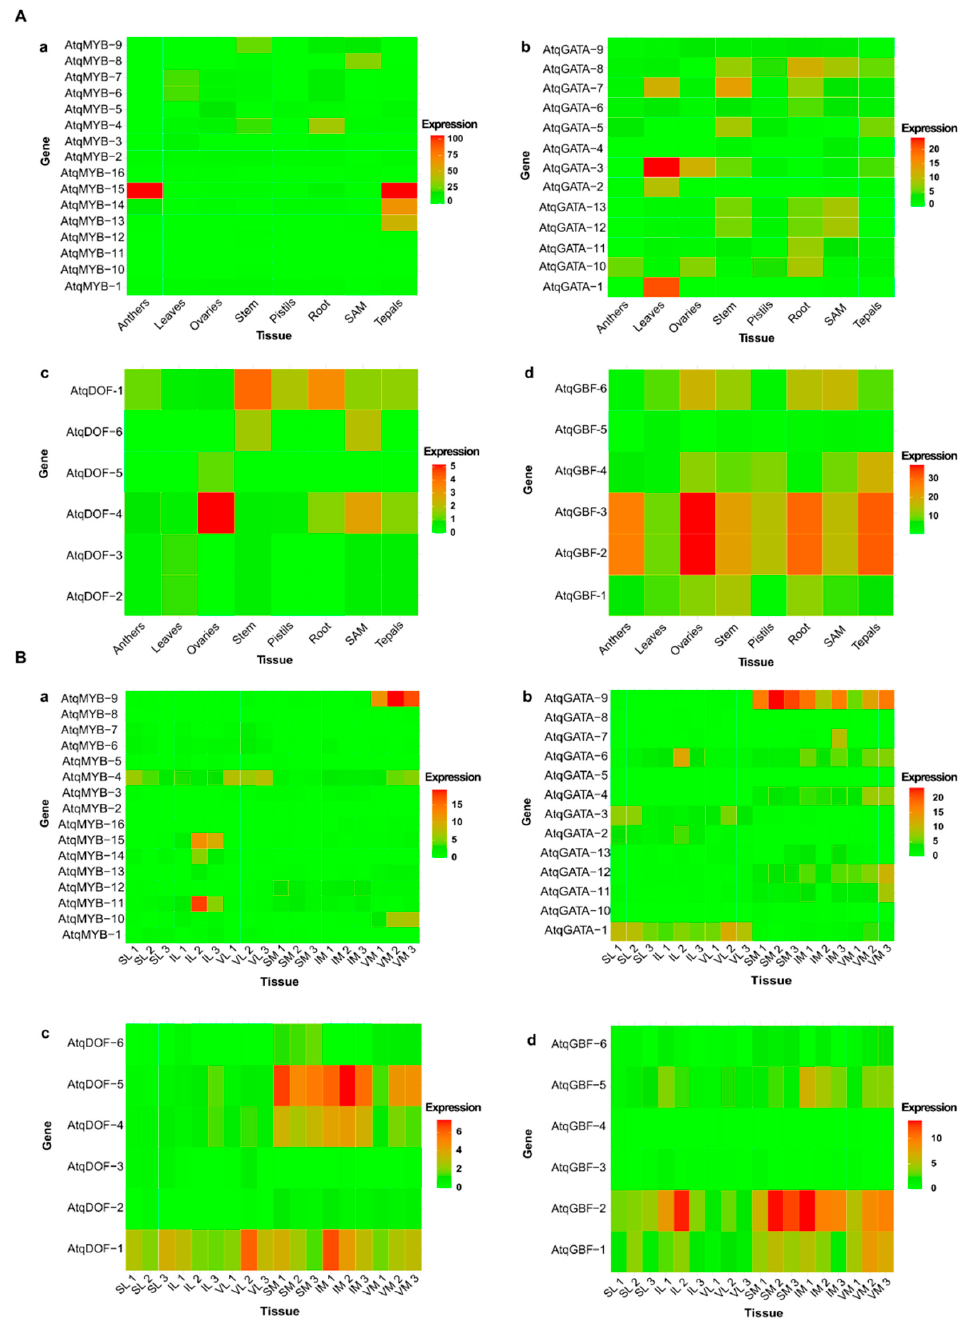
Figure 7. Heat diagrams of in silico gene expression patterns of ( a ) MYB genes, ( b ) GATA genes, ( c ) DOF genes and ( d ) GBF genes. ( A ) vegetative and floral tissues from A. tequilana plants as indicated on the x-axis, (2 different plants sampled for each tissue) and ( B ) during the vegetive to reproductive transition as indicated on the x-axis, (3 different plants sampled for each tissue) in A. tequilana plants. Red indicates the highest number of transcripts (expression) whereas green indicates the lowest number of transcripts (expression). VL, vegetative leaf, SL, sunken leaf, IL, inflorescence leaf, VM, vegetative shoot apical meristem, SM, sunken shoot apical meristem and IM, inflorescence meristem.